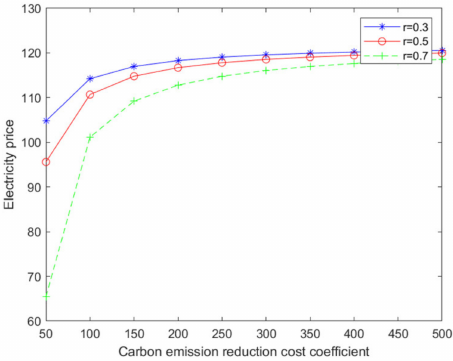
Figure 7. In the condition of centralized decision making with government carbon emission reduction subsidies, considering the proportion of different government carbon emission reduction subsidies, the impact of the carbon emission reduction cost coefficient on electricity prices shown.